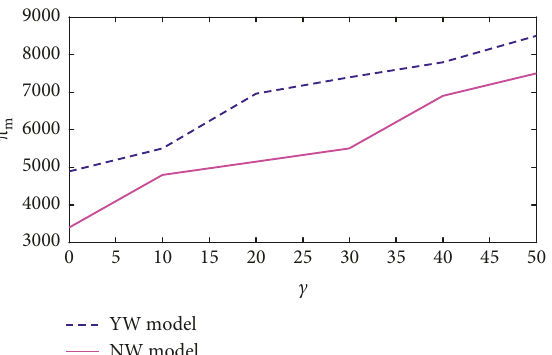
Figure 8: The impact of c on the manufacturer’s profit under the NW model and YW model.